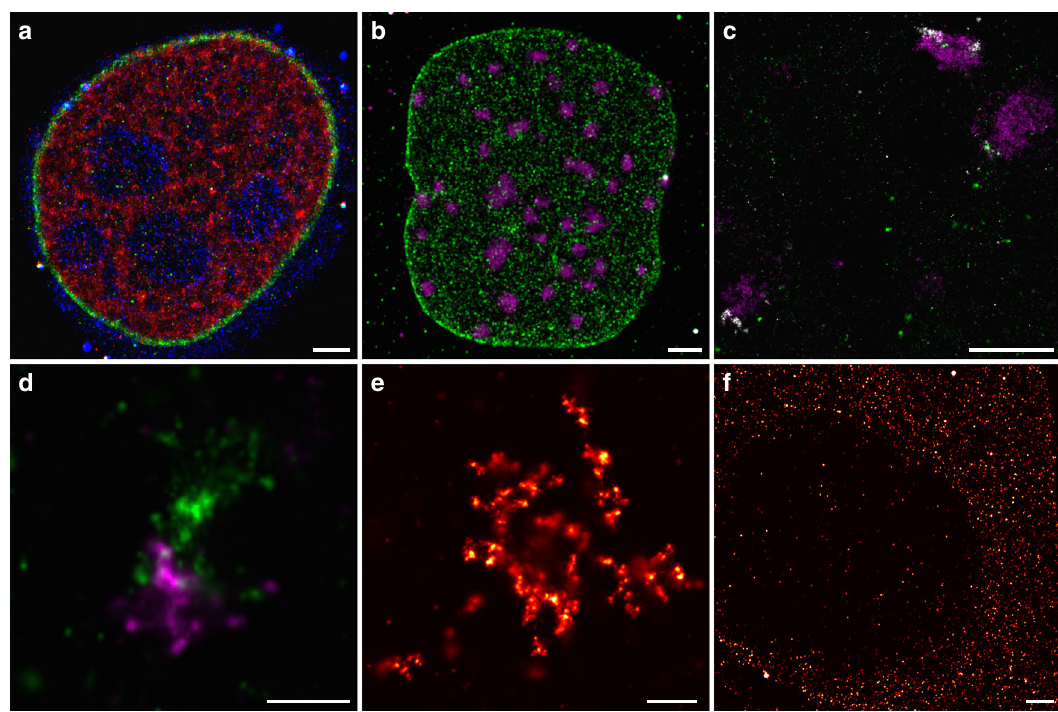
Fig. 4 DNA-PAINT imaging of distinct types of biomolecular targets at single optical sections. a Three-color immunostaining of fi xed HeLa cells for histone variant MacroH2A.1 (red), Lamin B (green), and nucleophosmin (blue) at 3.6 µ m height from the glass surface. b DNA FISH in EY.T4 mouse embryonic fi broblasts for the major satellite (magenta) and immunostaining for Lamin A (green) at 4.6 µ m height from the glass surface. c Three-color DNA FISH against the major satellite (magenta), minor satellite (white), and telomere regions (green) in mouse embryonic fi broblasts. d Two-color DNA FISH against single-copy targets at Xq28 in human female WI-38 fetal lung fi broblast cells. e RNA FISH against the Xist RNA in human female IMR-90 fetal lung fi broblast cells. f Single-molecule RNA FISH against the CBX5 mRNA in HeLa cells. Scale bars, 2 µ m ( a , b , and f ), 1 µ m ( c – e